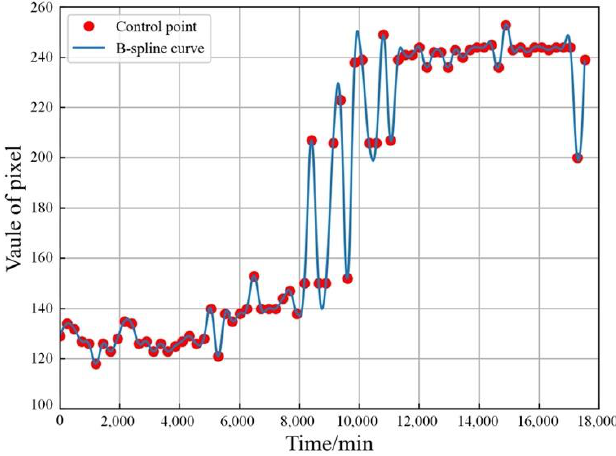
Figure 7. The example of B-spline curve.